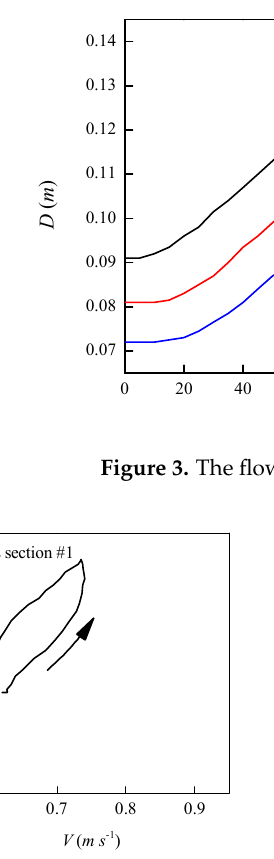
Figure 4. The relationships between cross-sectional averaged velocity and the flow depth at: ( a ) cross section #1, ( b ) cross section #2, and ( c ) cross section #3 in flood event No. 1-1.